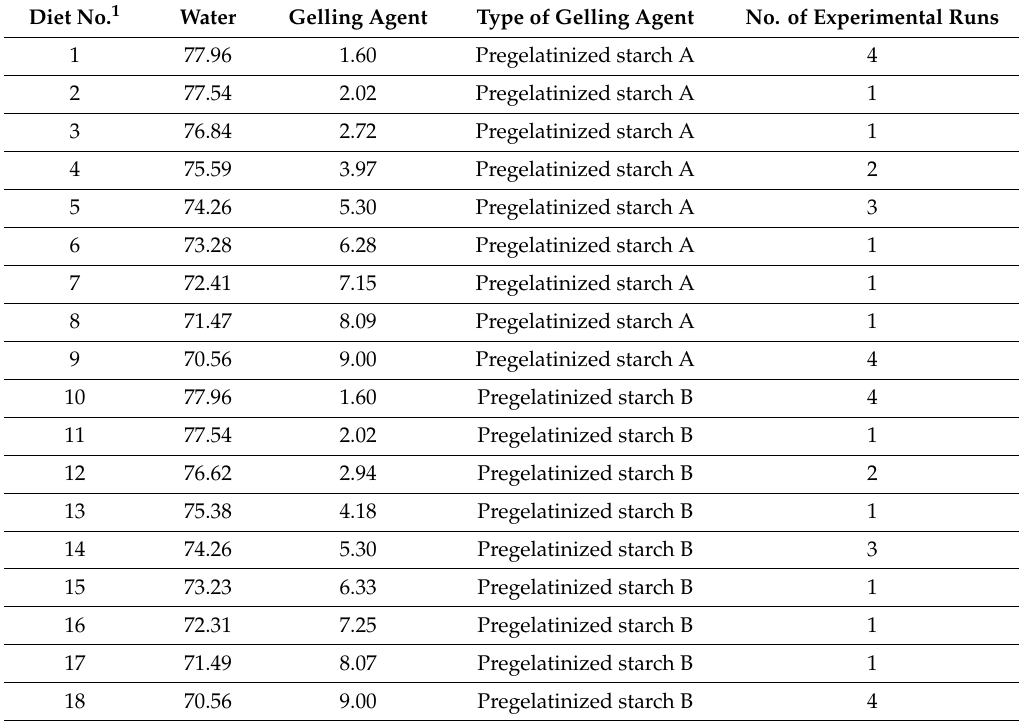
Table A1. Gel diet formulations tested in Experiment 1. The values of diet ingredients are given as percentages ( w / w